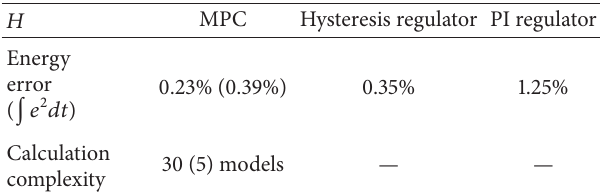
Table 1: Comparison of the results in the sinusoidal test current.